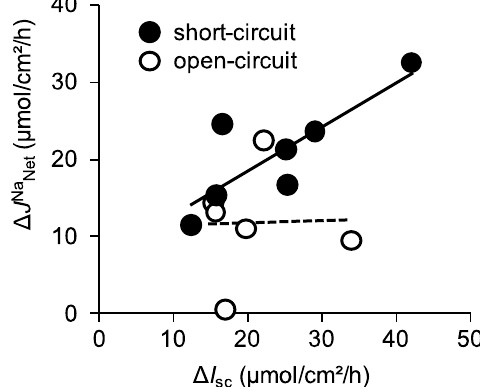
Figure 5. The relationship between changes of glucose-induced I sc and changes of glucose-induced net 22 Na + fluxes in cldn15 − / − mice: Glucose-induced ∆ I sc and J Na Net were calculated from the data of Figures 4 and 6 and replotted the same as in Figure 2. The lines were fitted by least-squares analysis. r 2 = 0.67 and 0.0012 for the short-circuit and open-circuit conditions, respectively. 2.6. Absence of Claudin-15 Increases Glucose-Induced Mucosal to Serosal 22 Na + Flux